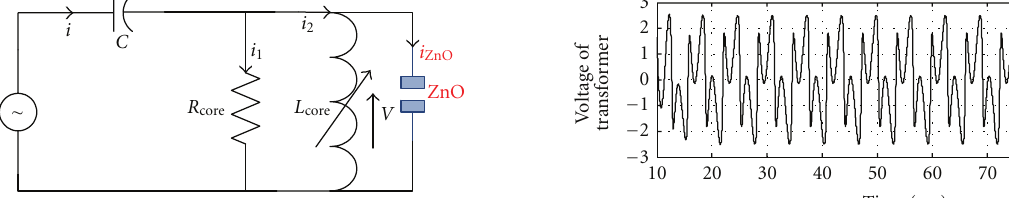
Figure 1: Final reduced model of power system for ferroresonance studies. Table 1: Typical value of q and its coe ffi cients.